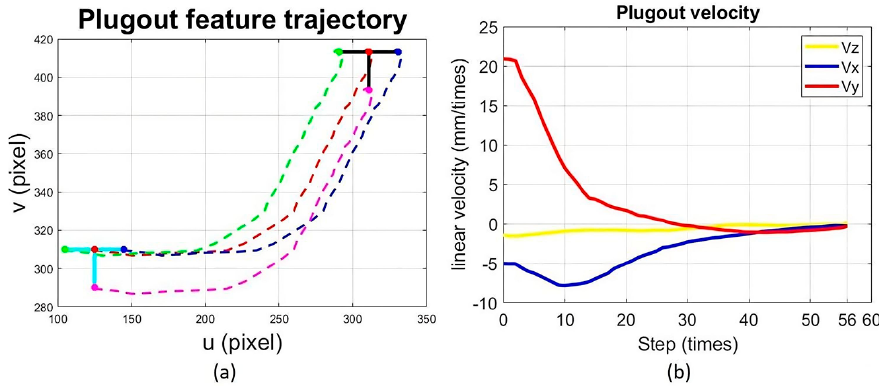
Figure 21. Plugging-in experiment: ( a ) trajectory of the feature points, ( b ) end-effector linear velocity v x , v y and v z .